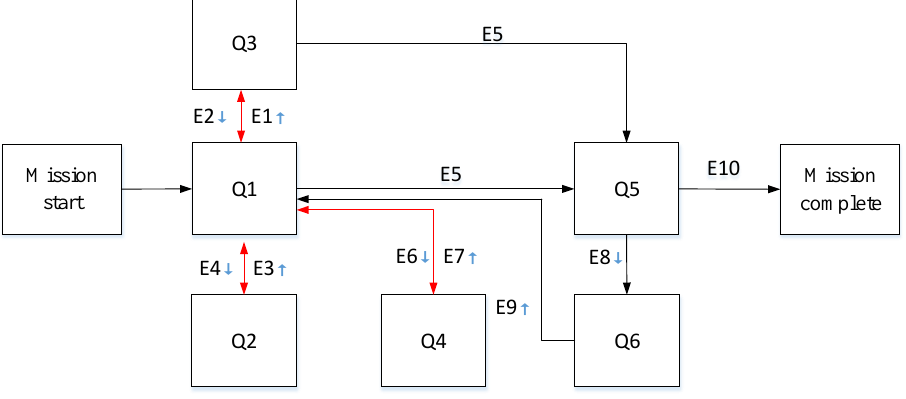
Figure 6. Bottom-layer state transition block diagram.